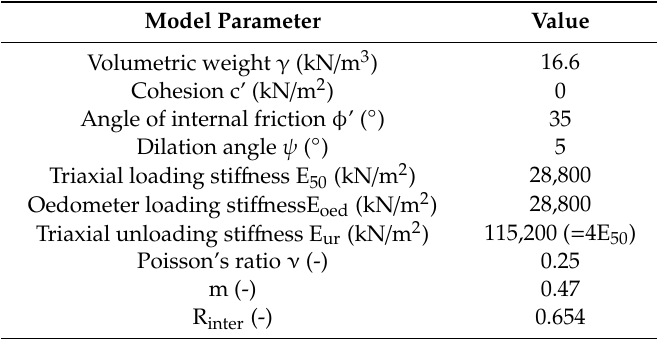
Table 2. Hardening soil model parameters after back-calculation of experimental results.